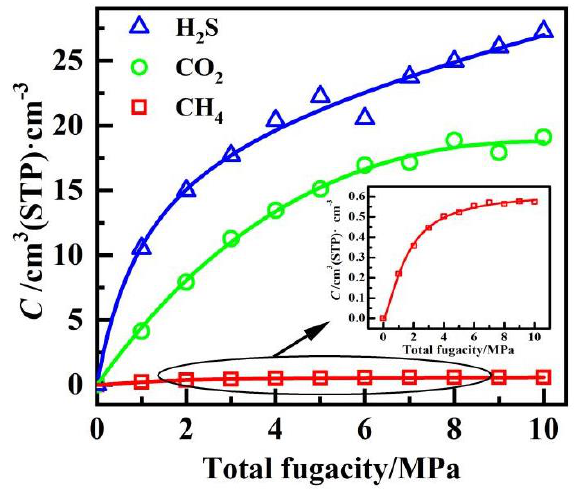
Figure 3. Adsorption isotherms of CH 4 /CO 2 /H 2 S mixed gases in PVDF at 30 °C.